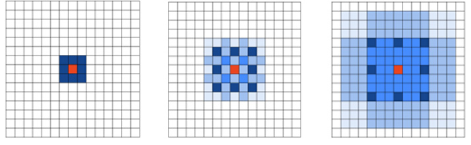
Figure 5. Atrous convolution with reasonable dilation rate.